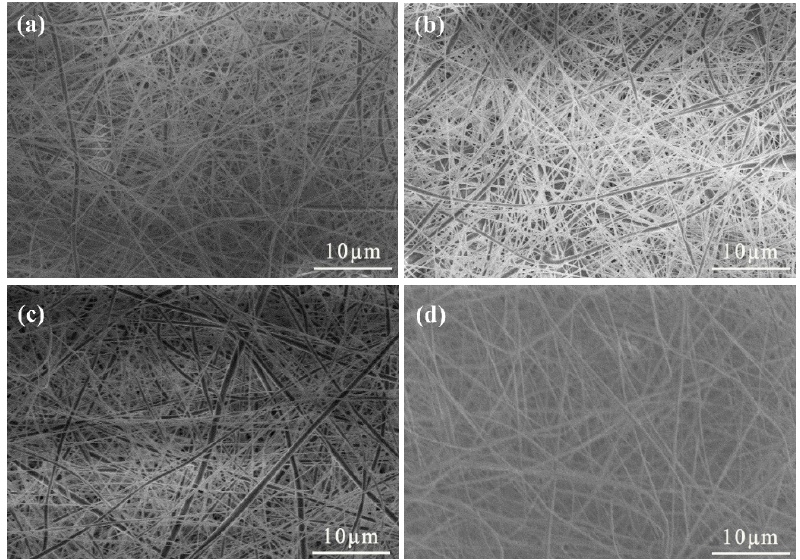
Figure 2. SEM images of PVDF/CA EFMs: ( a ) pure PVDF; ( b ) PVDF/CA-1; ( c ) PVDF/CA-2; ( d ) PVDF/CA-3.